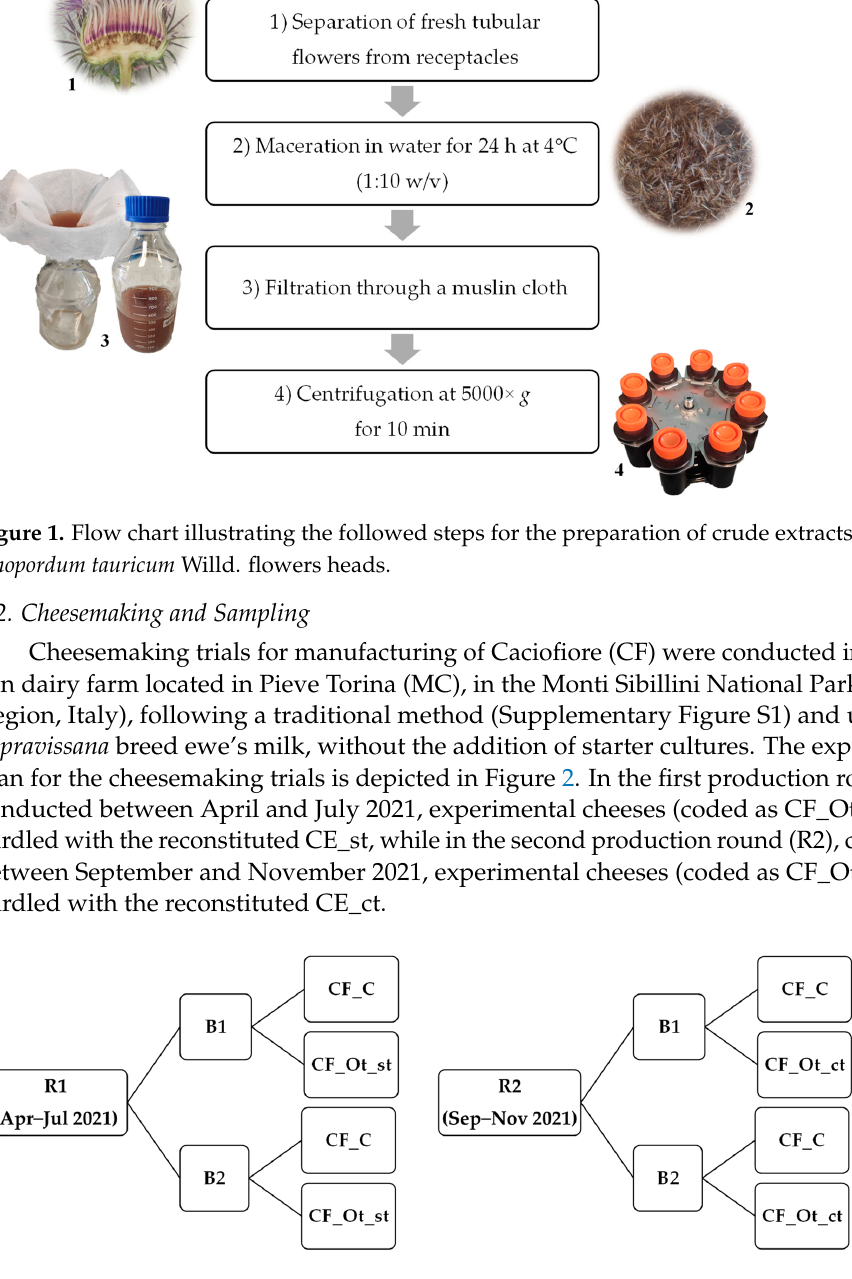
Figure 2. Experimental plan of the cheesemaking trials. Two production rounds were run, the first (R1) between April and July 2021, and the second (R2) between September and November 2021; for each Round, trials were repeated on two different days (Batch 1, B1, and Batch 2, B2, respectively). On the same day, both control (CF_C) and experimental (CF_Ot_st in R1 and CF_Ot_ct in R2) Caciofiore cheeses were produced.